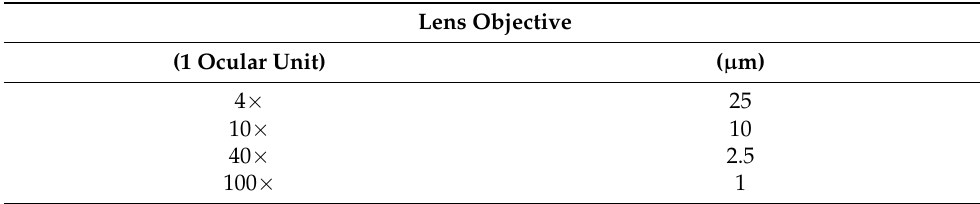
Table 1. Conversion of ocular lens measurements.